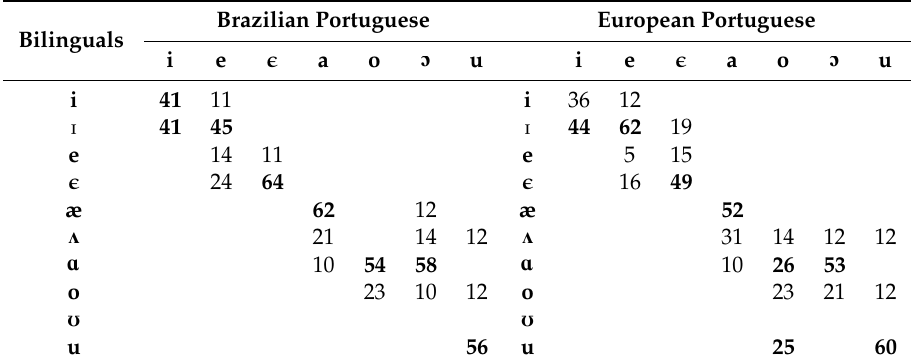
Table 2. Californian English monolingual listeners’ classification percentages for Brazilian Portuguese (BP, left) and European Portuguese (EP, right). The native vowel category with the highest classification percentage appears in bold and those percentages below chance (i.e., 10%) are not shown. Monolinguals